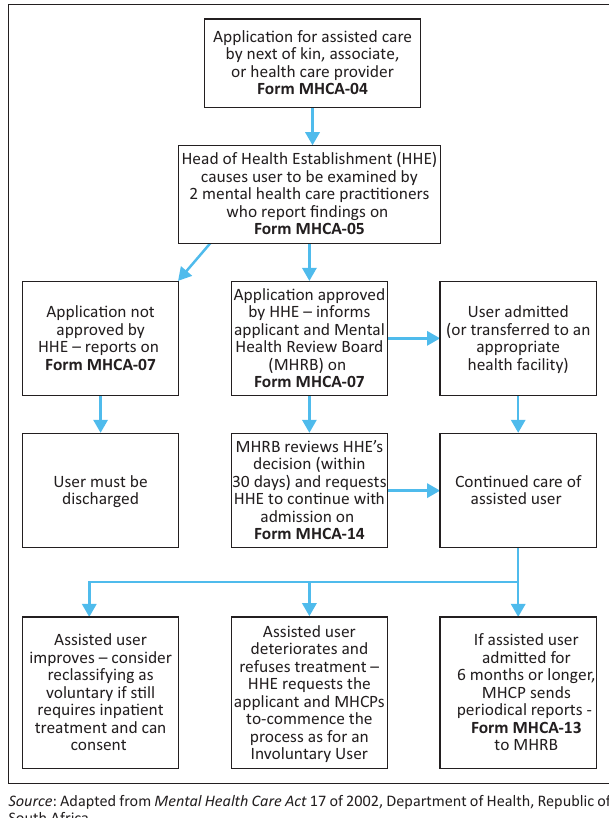
FIGURE 1: Procedure for assisted admission under the Mental Health Care Act